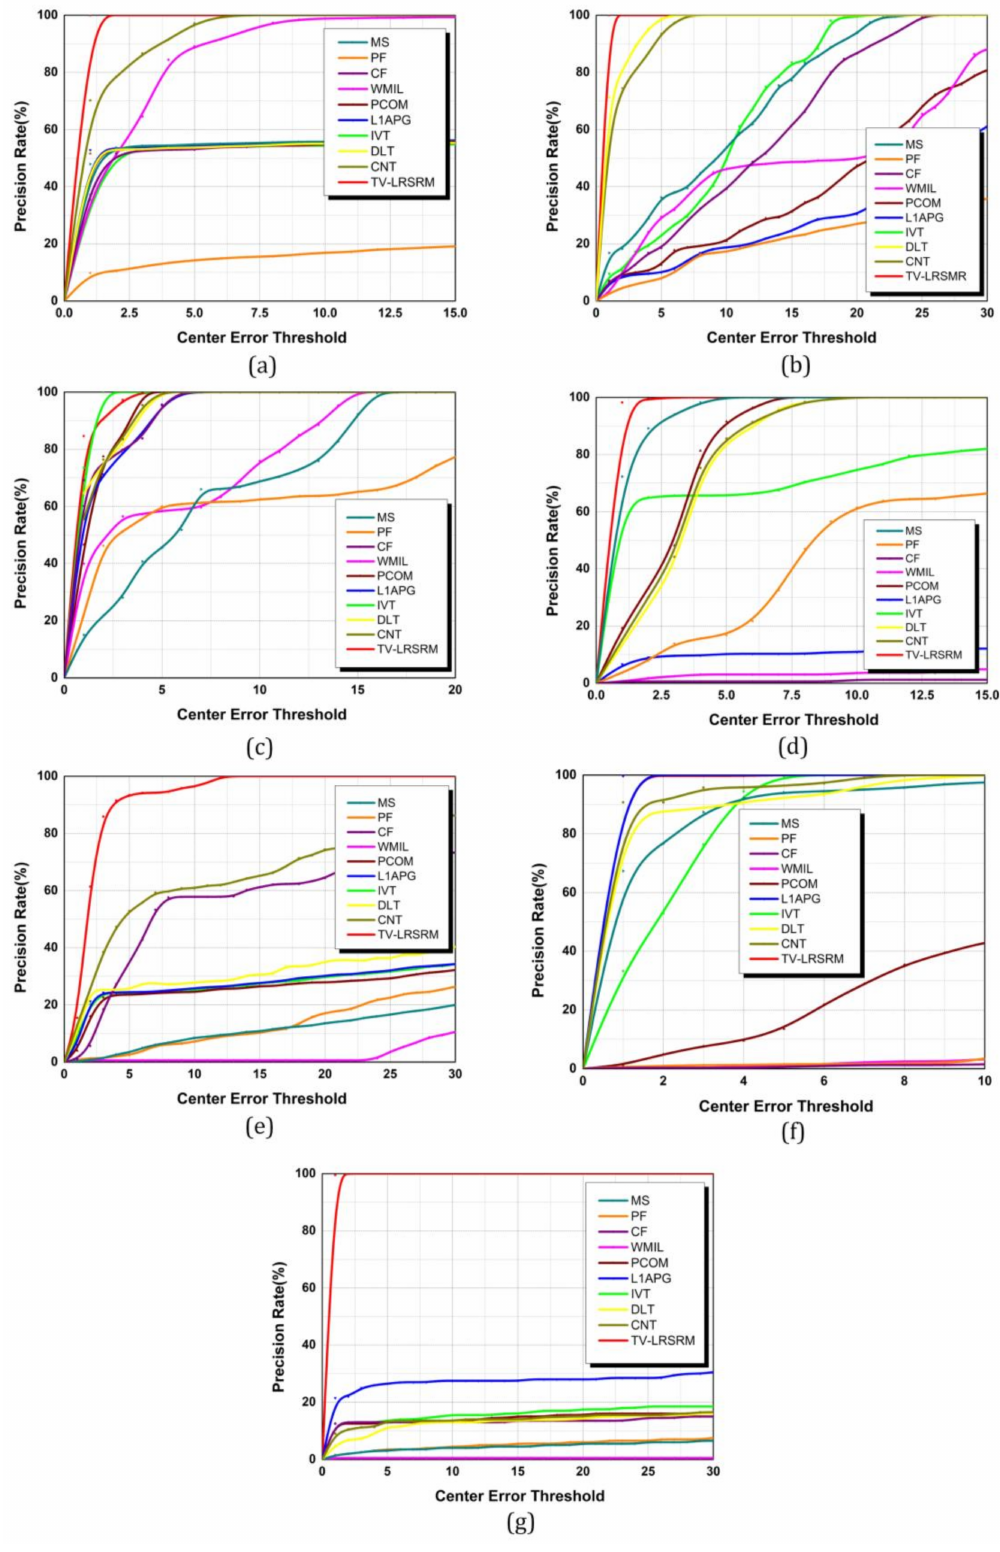
Figure 4. Precision plots: ( a ) Seq.1; ( b ) Seq.2; ( c ) Seq.3; ( d ) Seq.4; ( e ) Seq.5; ( f ) Seq.6; and, ( g )